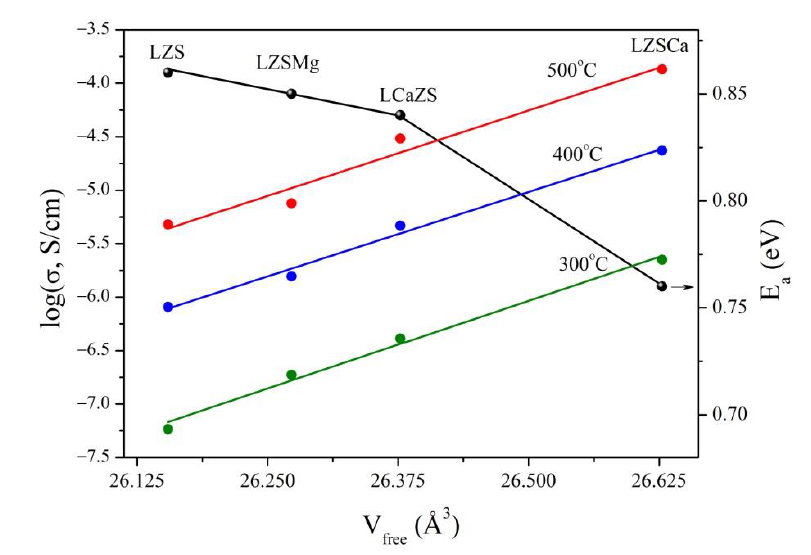
Figure 9. Comparison of the conductivities and activation energies as a function of the free lattice volume for the low-temperature (T < 500 °C) region in wet air for the samples: La 2 ScZnO 5.5 (LSZ), La 2 Sc 0.9 Mg 0.1 ZnO 5.45 (LZSMg), La 2 Sc 0.9 Ca 0.1 ZnO 5.45 (LZSCa), and La 1.9 Са 0.1 ScZnO 5.45 (LCaZS).